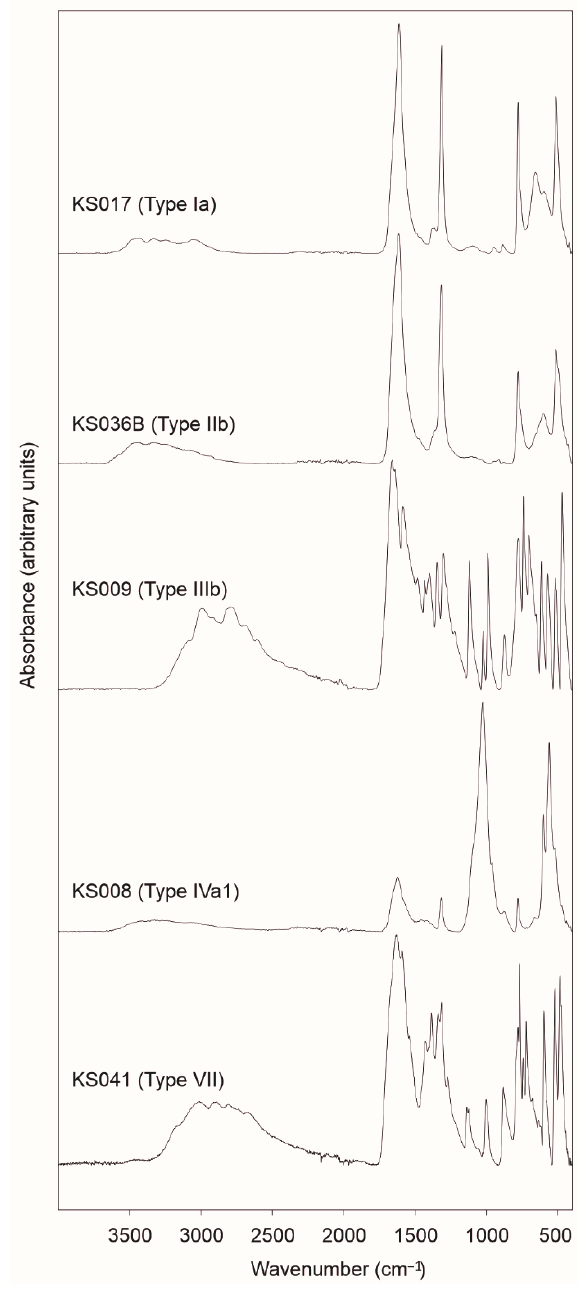
Figure 4. Representative FTIR spectra of the examined uroliths: whewellite in sample KS017 (type Ia); weddellite in bladder stone KS036B (type IIb); uric acid in sample KS009 (type III); carbonated apatite in sample KS008 (type Iva1); ammonium urate and calcium oxalate in mixed stone KS041 (type VII).